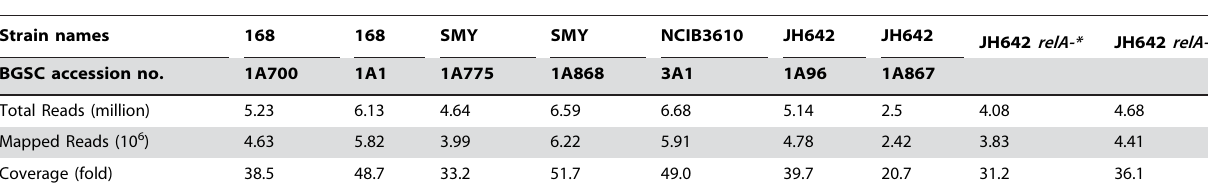
Table 1. Summary of sequence reads and coverage.